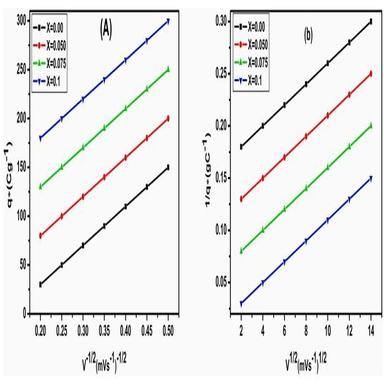
Dependence of (a) voltammetric charge (q) with inverse square root of scan rate (V− 1/2) and (b) dependence of inverse voltammetric charge (1/q) with square root scan rate (V1/2) of CoFe2-xSmxO4 x = 0.0, x = 0.050, x = 0.075 and x = 0.1 ferrites.